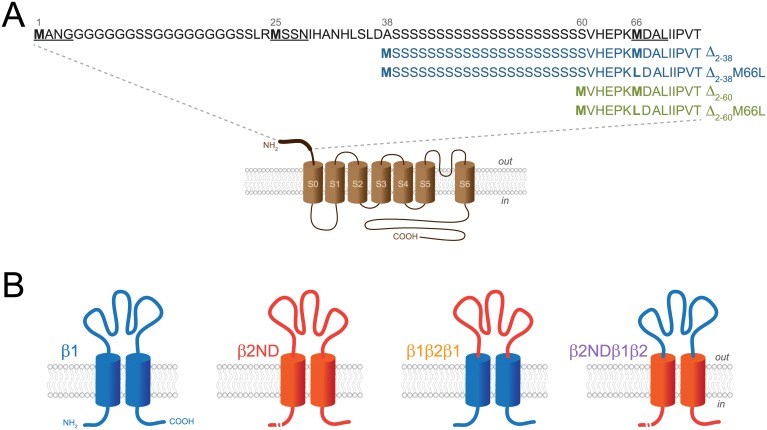
BKCa α-subunit N-terminal, β1, β2ND and β1-β2 chimeric constructs.A, Schematic representation of the BKCa α-subunit N-terminal sequence and truncated constructs. Names used for the N-terminal constructs are underlined in the sequence of the BKCa α-subunit. N-terminal sequences of the four truncated constructs used in this study are shown; Δ2–38, Δ2-38M66L, Δ2–60 and Δ2-60M66L. B, Schematic representation of BKCa β1, β2ND and β1-β2 chimeric constructs used in this study.